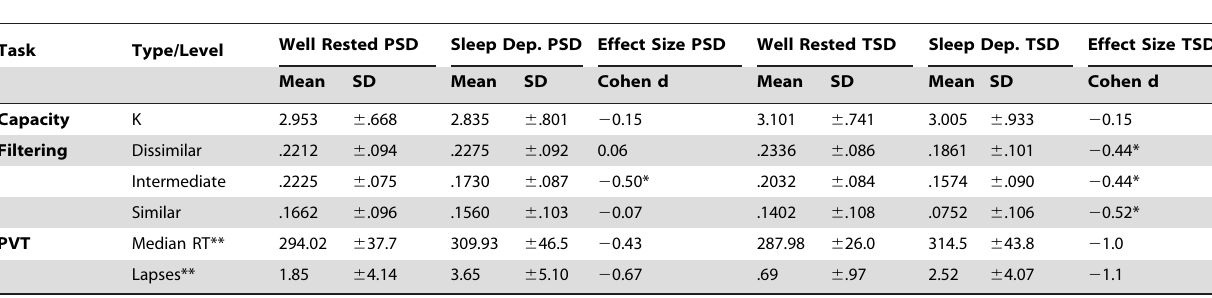
Table 3. Task Performance and Effect